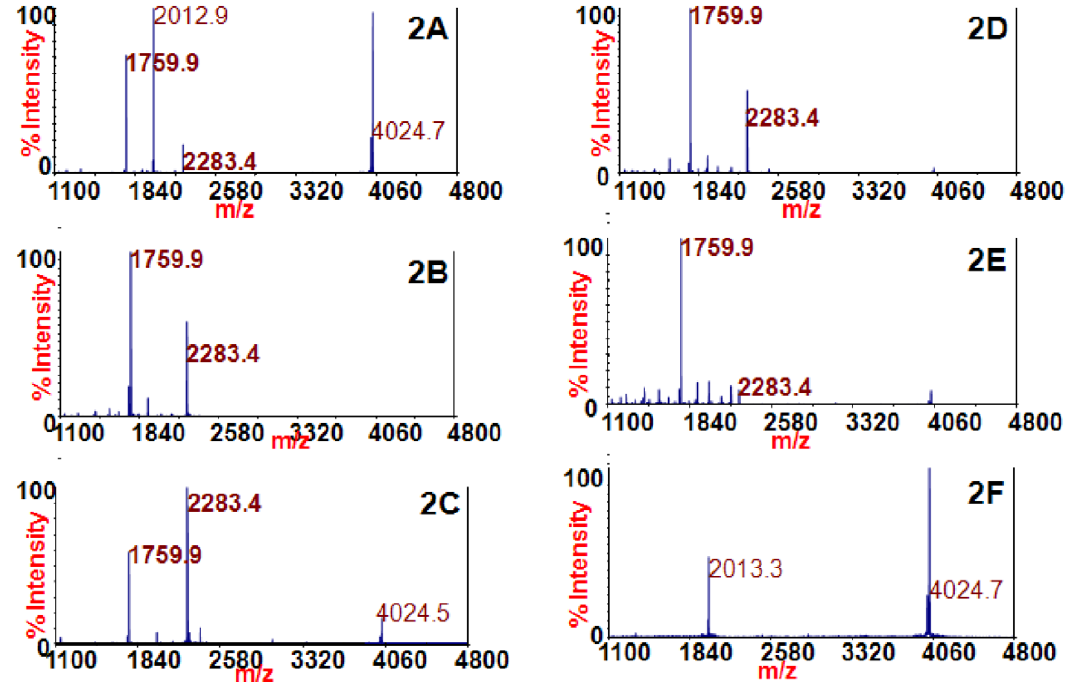
Figure 2. Mass spectra of the Endopep-MS BoNT/B reactions with /B1 (2A), /B2 (2B), /B3 (2C), /B4 (2D), /B5 (2E), or no toxin (2F) extracted using the 4E17.1 antibody-coated beads. The peptide cleavage products indicating BoNT/B are m/z 1759.9 and 2283.4 and the peptide substrate is present at m/z 4024.7.